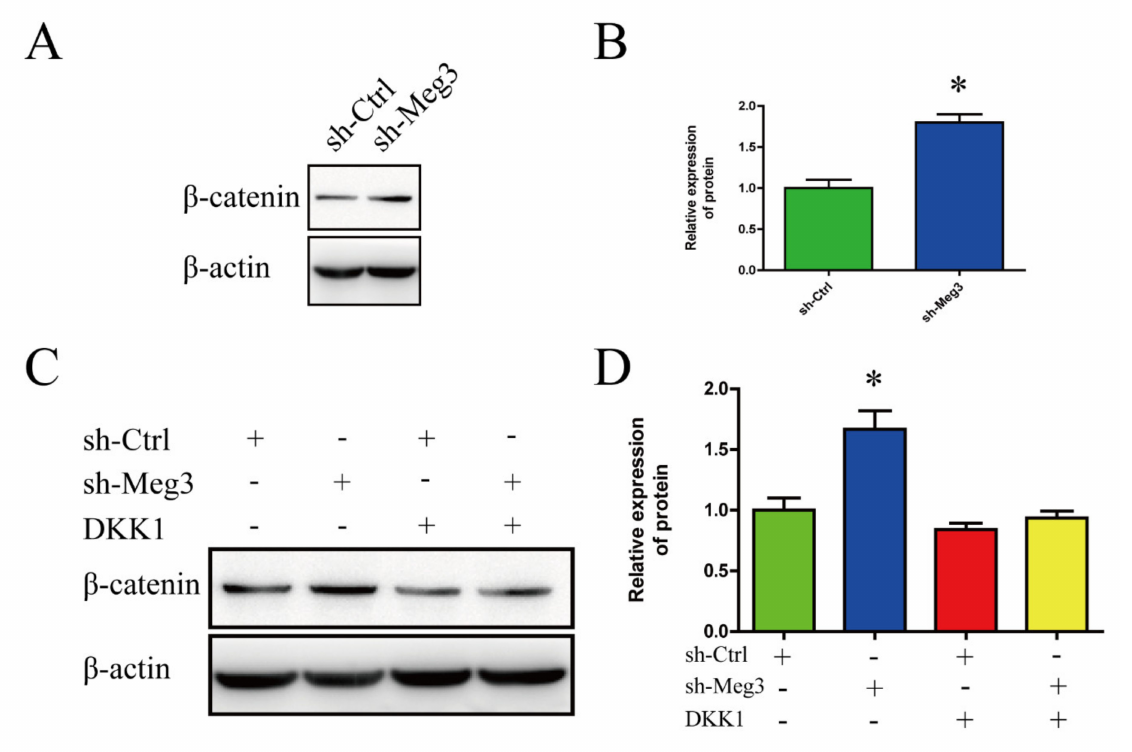
Figure 3. MEG3 regulates wnt/ β -catenin signaling. ( A , B ) Representative immunoblot and bar graph show the relative expression level of β -catenin in sh-ctrl and sh-Meg3. ( C ) sh-Ctrl and sh-Meg3 BMSCs were treated with or without Wnt/ β -catenin signaling inhibitor (DKK1). The expression of β -catenin in sh-ctrl, sh-ctrl + DKK1, sh-Meg3, and sh-Meg3 + DKK1 groups were determined by Western blot analysis. ( D ) Bar graph shows quantification expression of β -catenin in sh-ctrl, sh-ctrl + DKK1, sh-Meg3, and sh-Meg3 + DKK1 groups (n = 3/group). * p < 0.05 versus